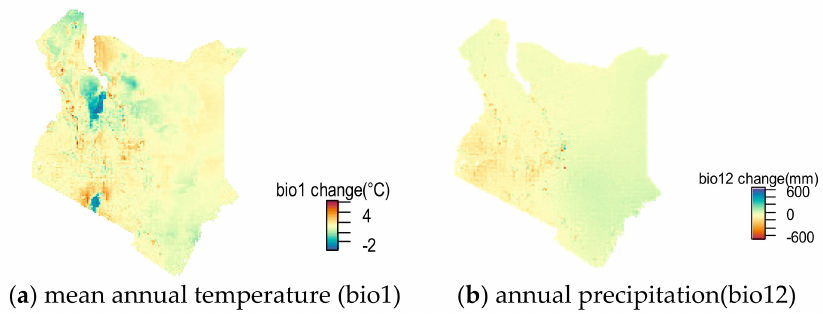
Figure 2. Projected changes in ( a ) mean annual air temperature and ( b ) annual precipitation between the present and 2050, according to MIRO-ES2L under the RCP 4.5 scenario.